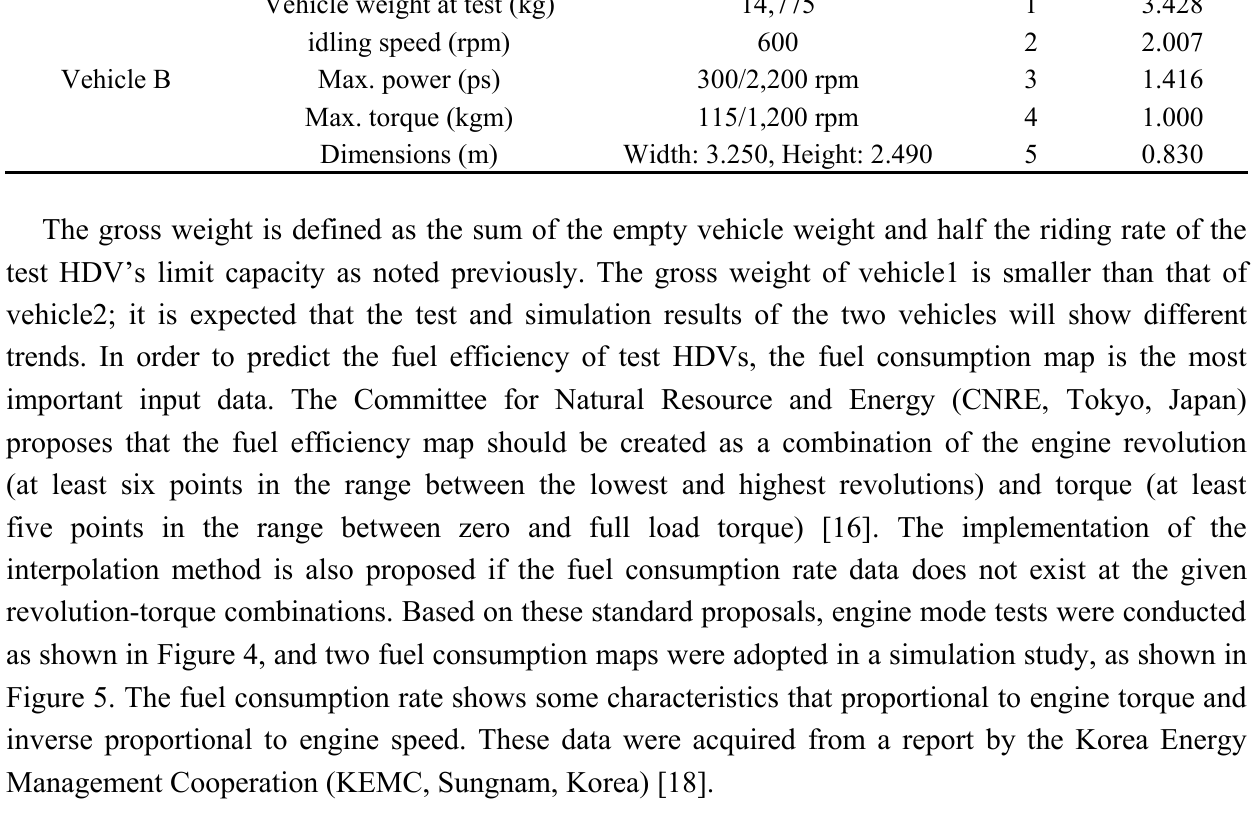
Figure 4. Engine test